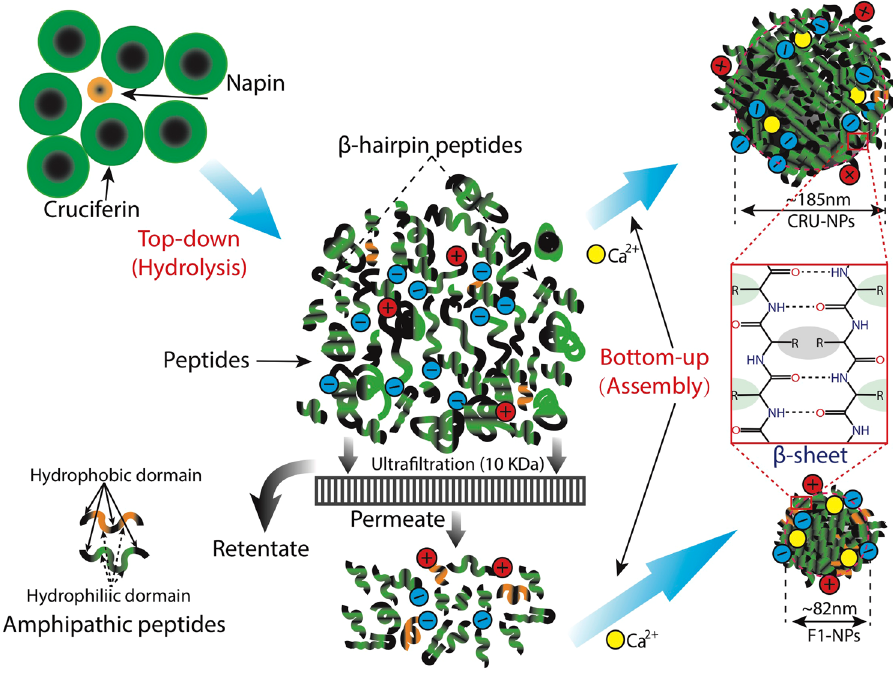
Figure 7. Schematic illustration of the assembly of cruciferin